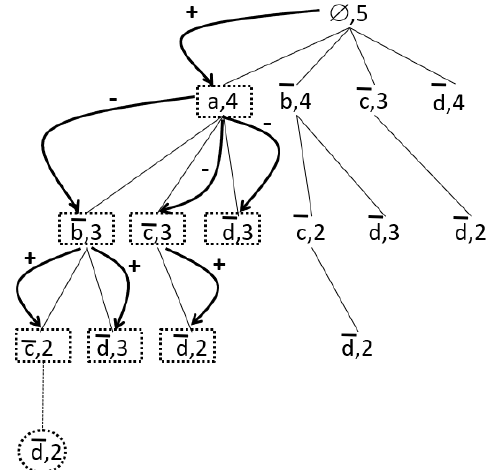
Figure 3. Partial-Computation-Support at work for the candidate literalset abcd